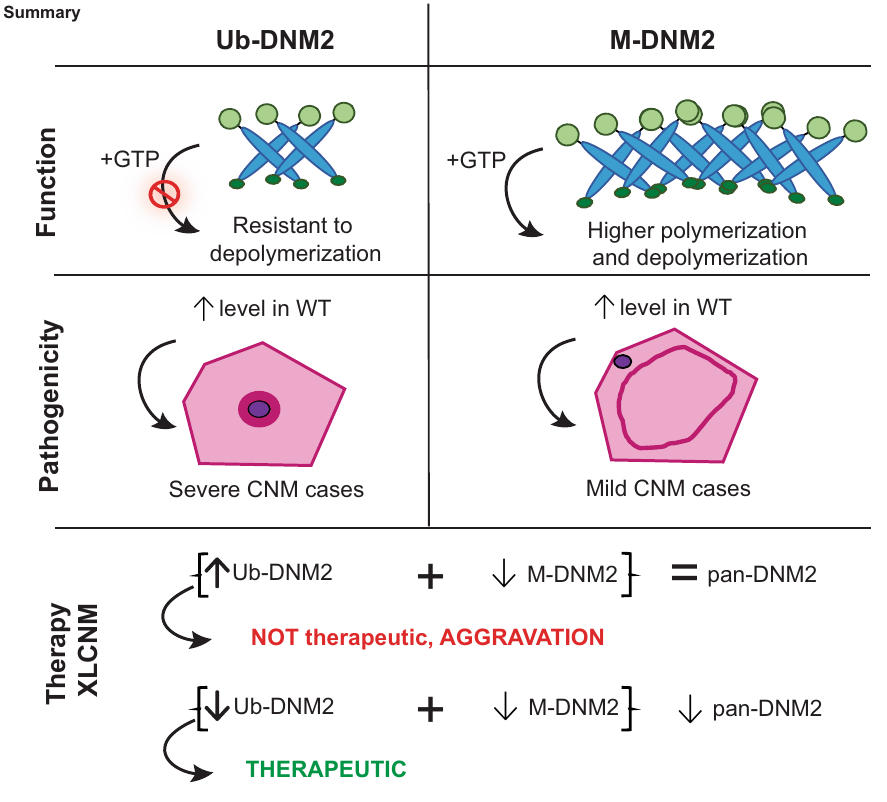
Fig. 9 | Summary of the differential function and implications of DNM2 iso- forms at pathophysiological and therapeutic levels. Function: M-DNM2 was shown to form higher-order oligomer structures, while having faster GTP kinetics and higher sensitivity to GTP-induced depolymerization compared to Ub-DNM2 thatwasmoreresistanttodepolymerizationinpresenceofGTP.Pathogenicity:the differentialmolecularregulationof Ub-DNM2andM-DNM2underlythatUb-DNM2 exogenously expressed in mouse WT muscles triggered a severe CNM histology